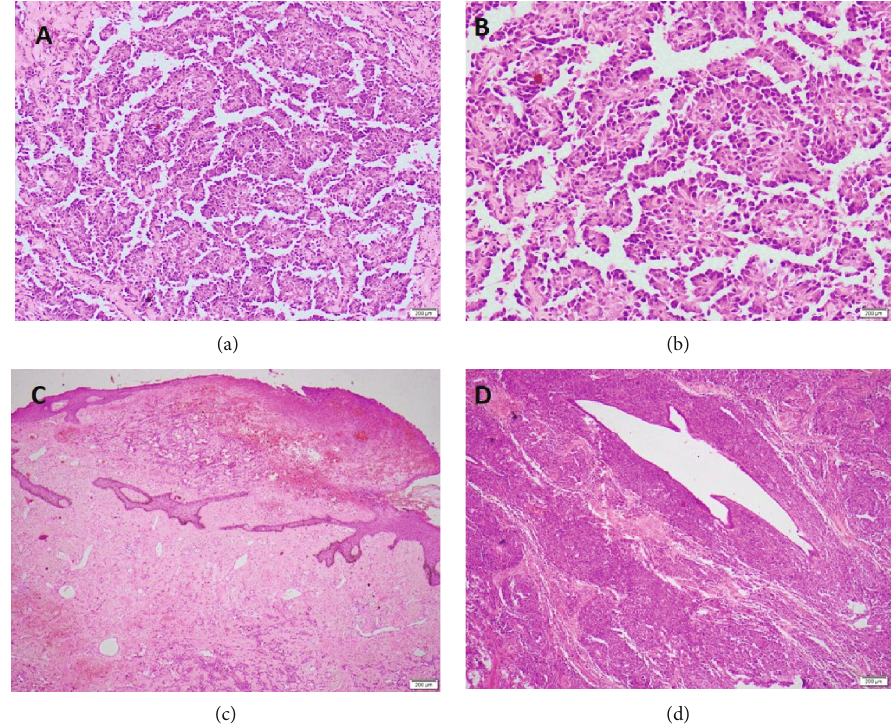
Figure 2: (a and b) Microscopic analysis showing anastomosing channels of vascular spaces lined by atypical cells with markedly pleomorphic vesicular nuclei and moderate eosinophillic cytoplasm. (c) Di ff use sheets and in fi ltrating cords of cells, areas of necrosis and blood lakes. (d) Tumour in fi ltration around the mammary ducts and surrounding fatty tissues.